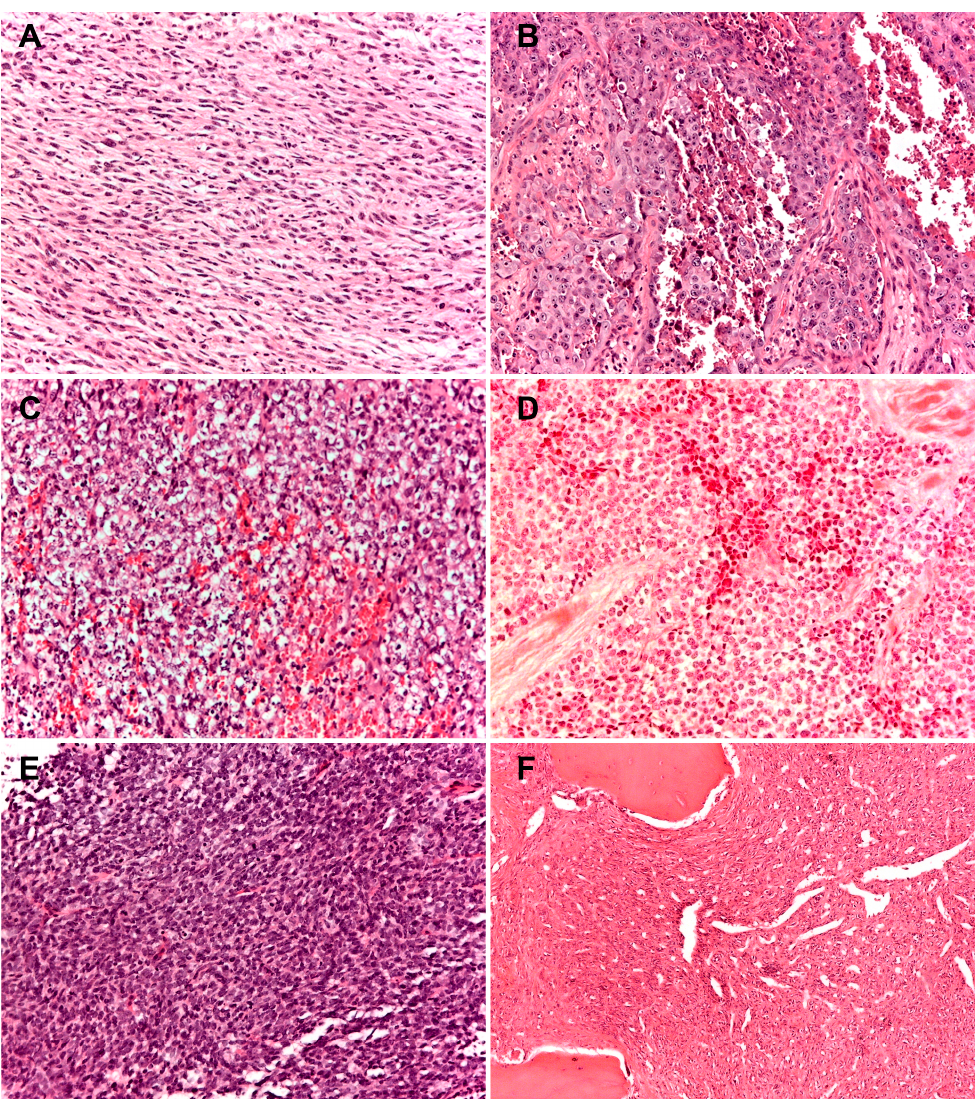
Figure 2. ( A ) Spindle cell sarcoma of bone: tumor cells are typically organized in a fascicular or herringbone pattern; ( B ) angiosarcoma of bone: tumor is composed of a markedly atypical, predominantly solid epithelioid cell proliferation, featuring abundant eosinophilic cytoplasm, often harboring macronucleolated vesicular nuclei; ( C – E ) round cell sarcomas; ( C ) CIC-DUX4; ( D ) undifferentiated round cells sarcoma; ( E ) BCOR-CCNB3; ( F ) solitary fibrous tumor of bone with a classic hemangiopericytomatous pattern. (100 × of magnification; haematoxylin and eosin